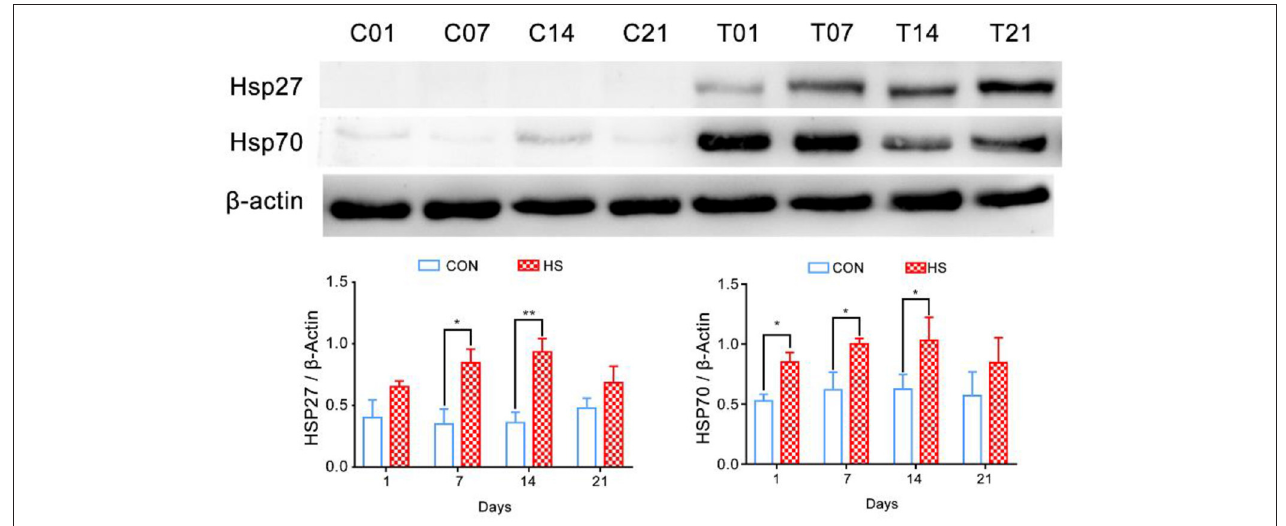
FIGURE 2 | Effect of heat stress on relative expression of heat shock proteins in pigs’ colonic tissue. * p < 0.05, ** p < 0.01 compared with each group.